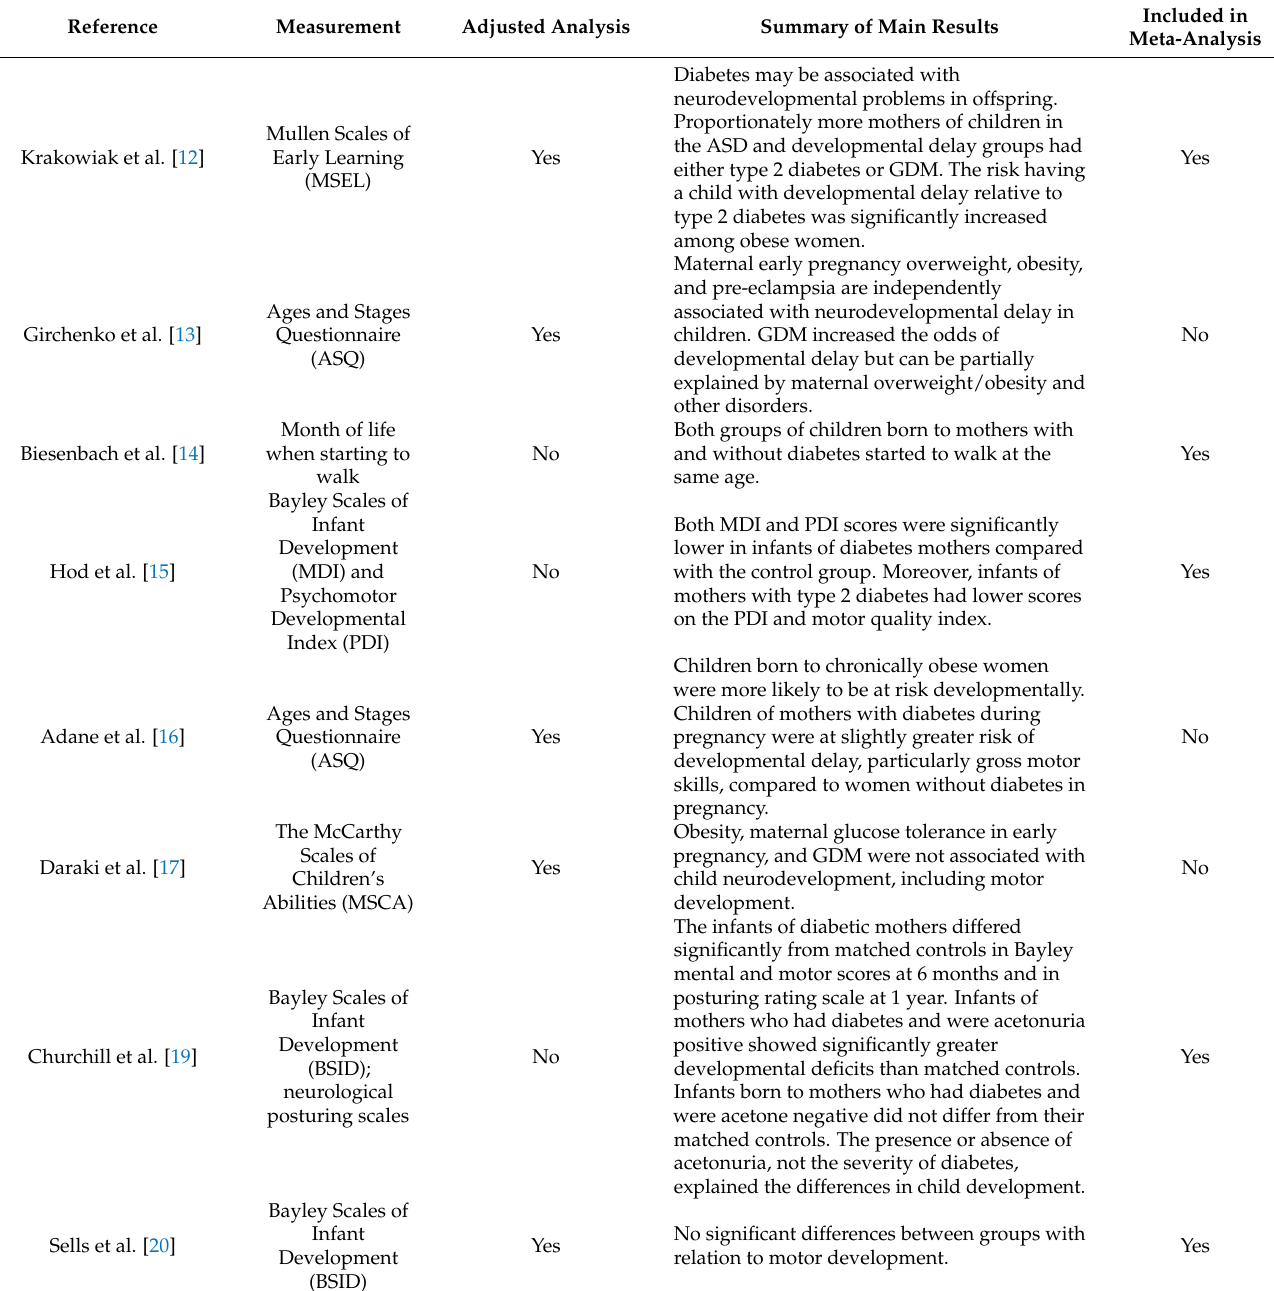
Table 2. Summary of results of included